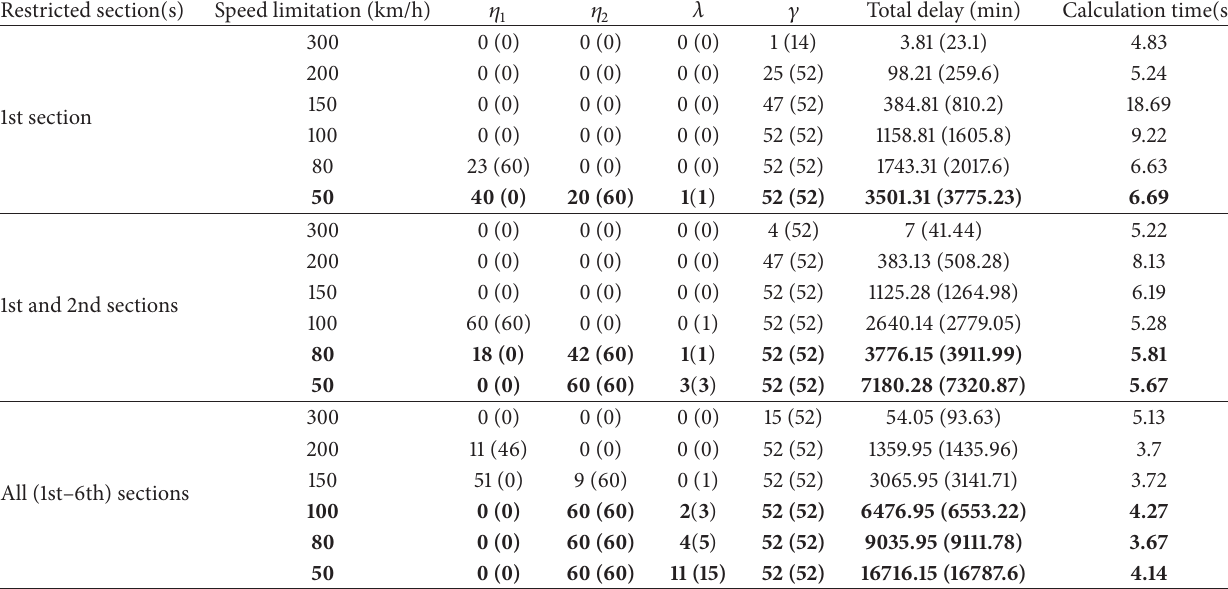
Table 4: Evaluation results on the rescheduled